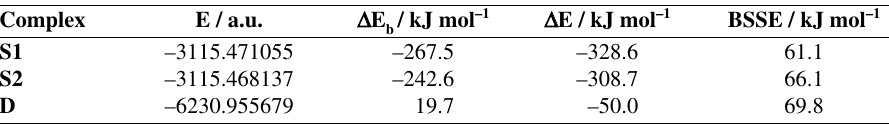
Table 2. Energies (in a.u.) and bonding, and interaction energies of the single complexes S1 and S2 and of the dimeric aggregate D (in kJ mol –1 )